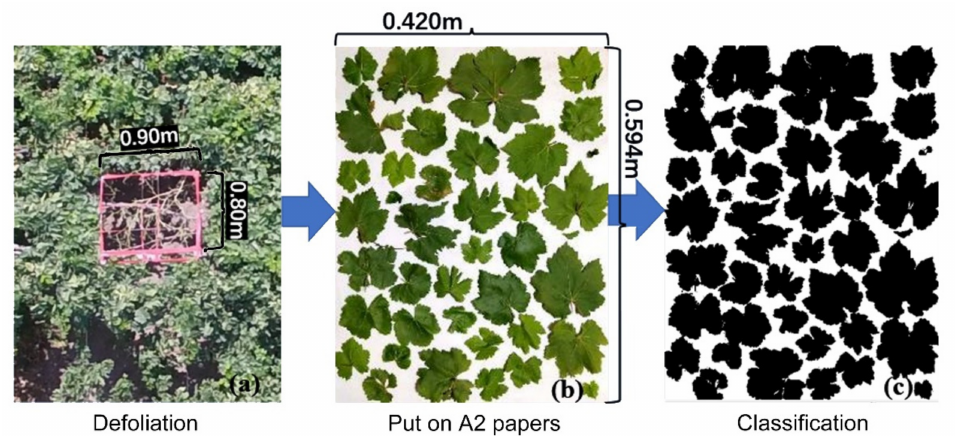
Figure 2. Calculation procedure of true LAI values: ( a ) collect all leaves inside the rectangular frame; ( b ) put leaves on A2 paper and take photo with RGB camera; ( c ) distinguish the leaves and calculate the area.